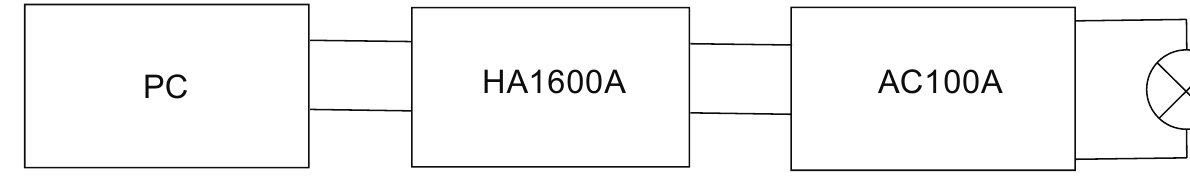
Figure 2. Schematic of the measuring station.